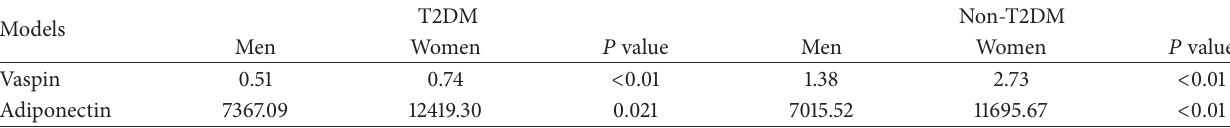
Table 8: Comparisons of serum vaspin and adiponectin levels divided by gender and